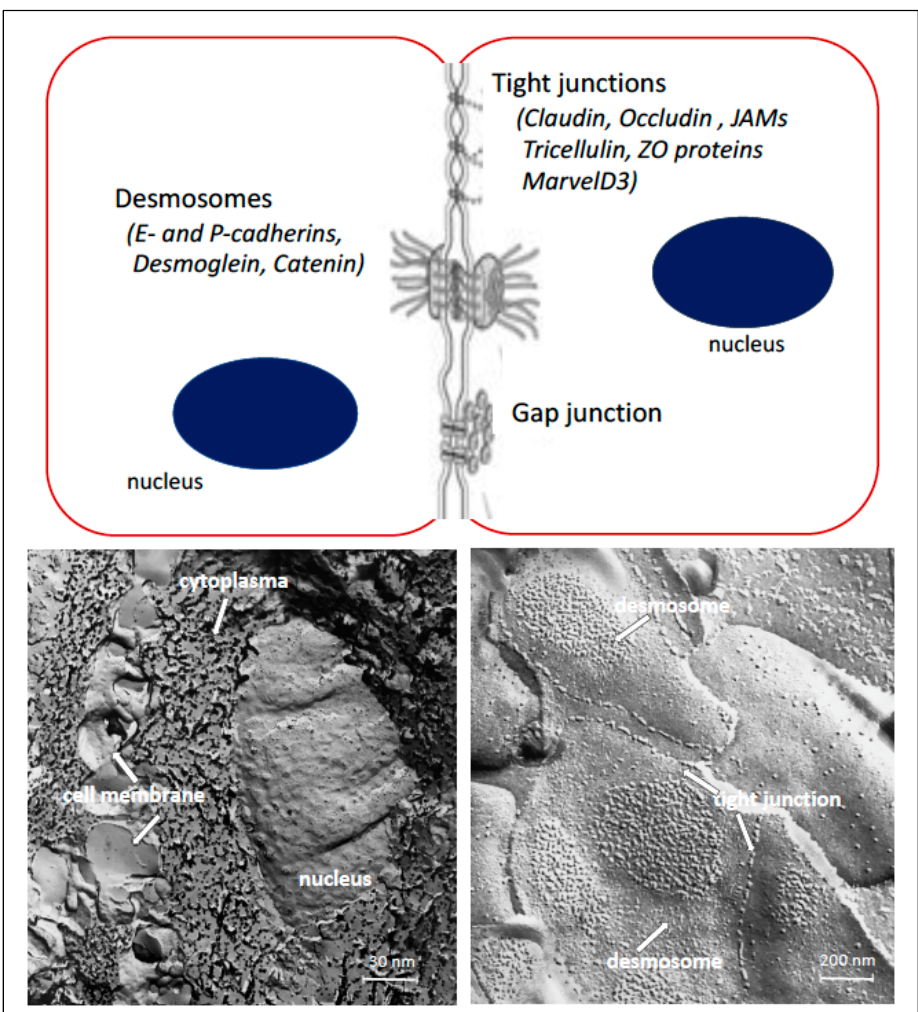
Figure 2. Cell junctions in the oral epithelium and freeze fracture micrographs of intact buccal epithelium; freeze fracture micrograph on the left side depicts cell nucleus, cytoplasm and cell membrane, on the right side, TJs and desmosomes between cells are shown at larger magnification.